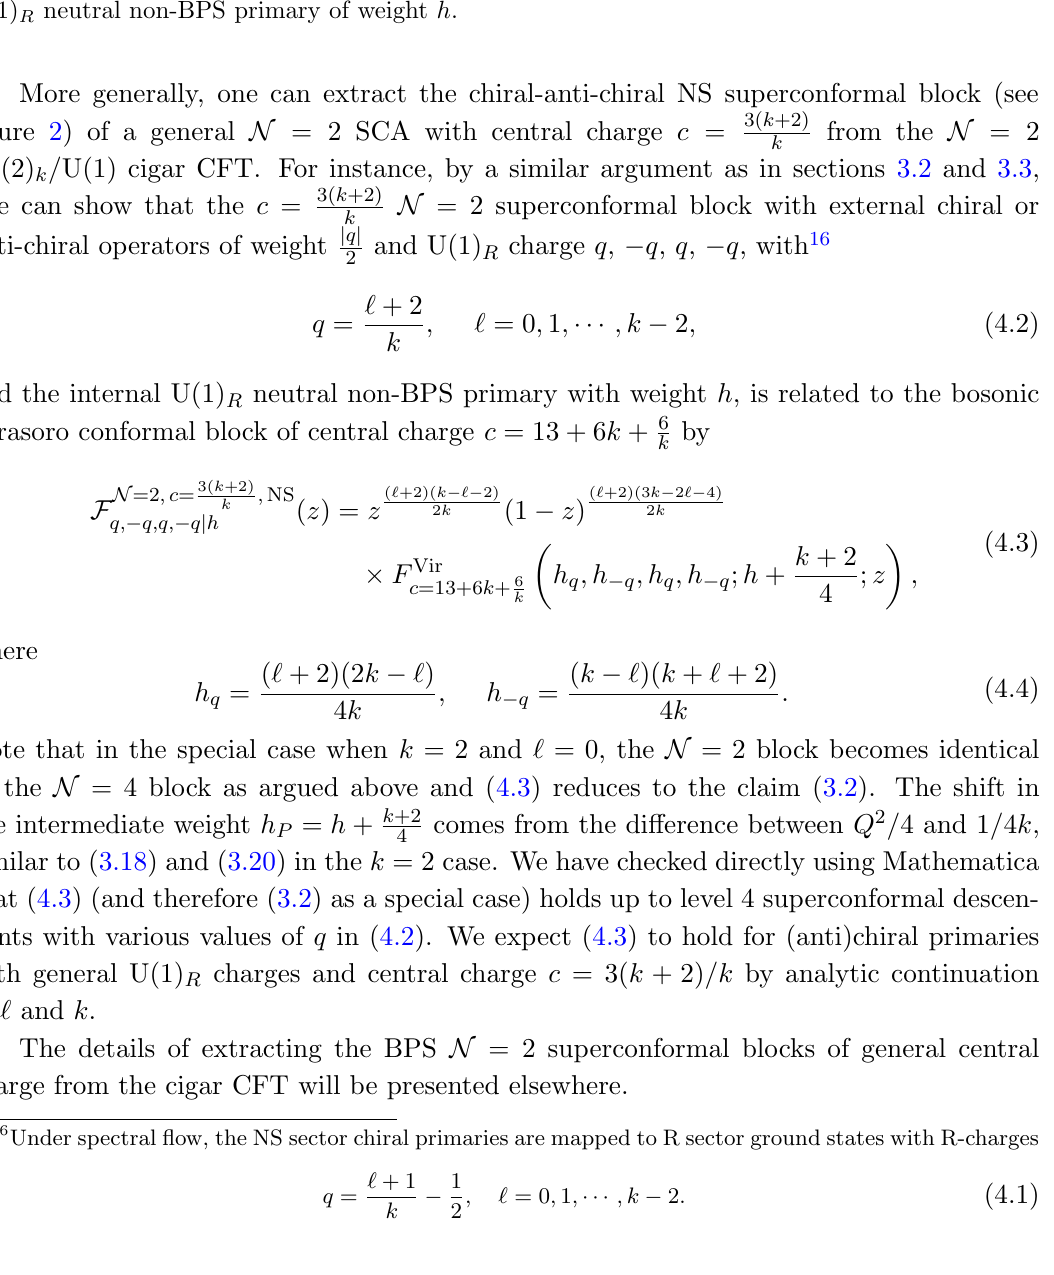
NS = 2 superconformal block with external k N (cid:0) ‘ +2 (cid:1) and U(1) R charge q = , and intermediate 2 k (cid:6) (cid:6)